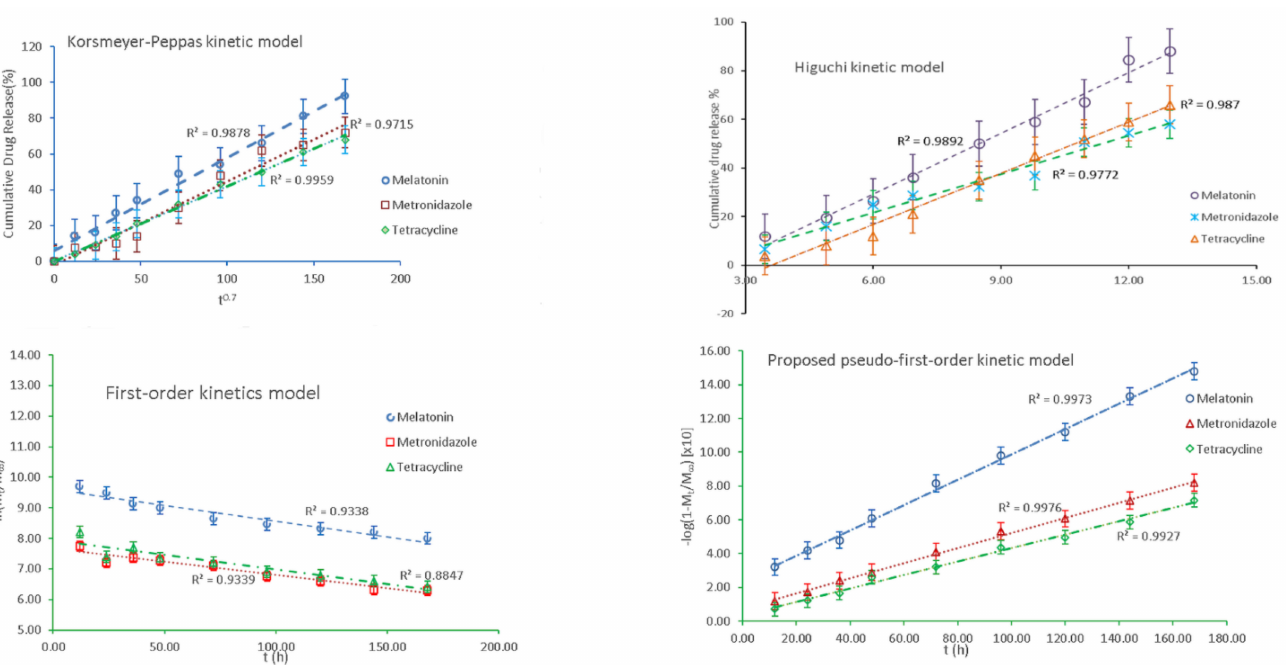
Figure 10. The kinetic models describing the release mechanism for each active